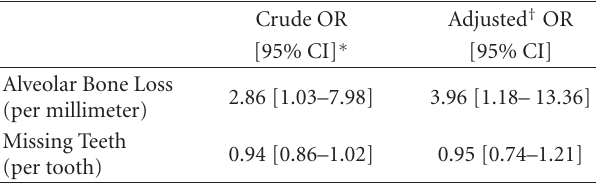
Table 4: Odds Ratios for Tumor HPV Status Associated with Periodontal